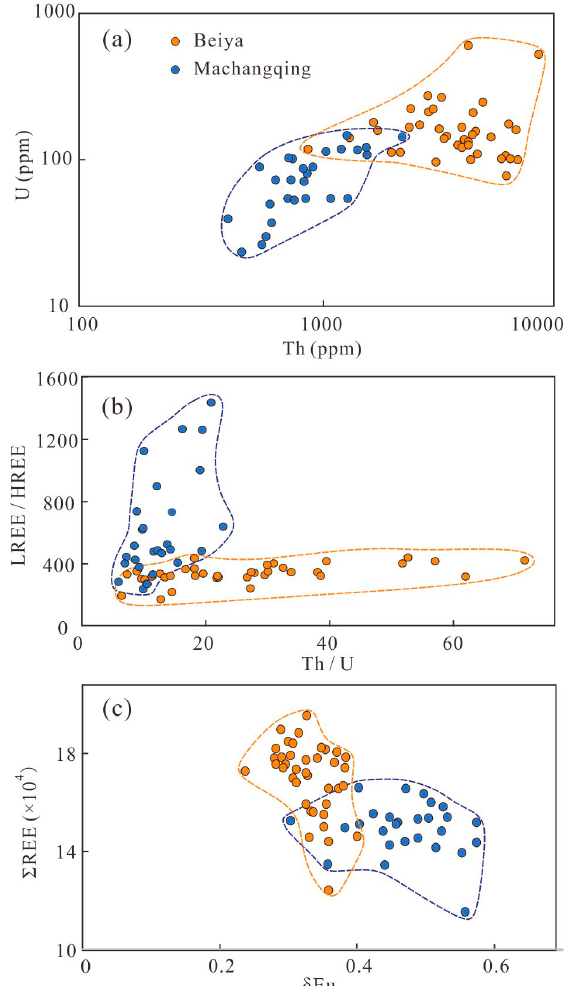
Figure 7. Plots of: ( a ) Th vs. U; ( b ) Th/U vs. LREE/HREE (light rare earth element divide heavy rare earth element); and ( c ) total REE ( Σ REE) vs. δ Eu in the allanite from the Beiya and Machangqing deposits.